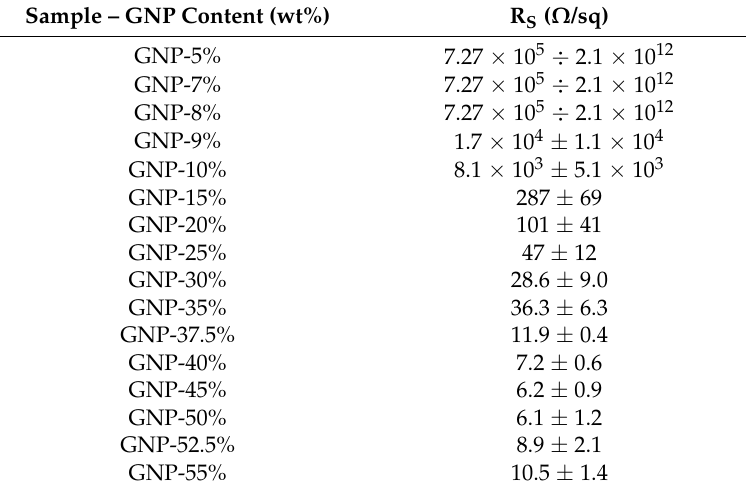
Table 1. Proportions for prepared RTV/GNP pastes and respective sheet resistance values (R S ), errors are one standard deviation (not given for samples below 9 wt% due to route resistance exceeding measurement range); for samples below 9 wt% GNP, measured resistance exceeded ohmmeter upper limit of measurable resistance, so it was assumed as the lower limit of sample resistance, upper limit is derived from the bare silicone characteristics